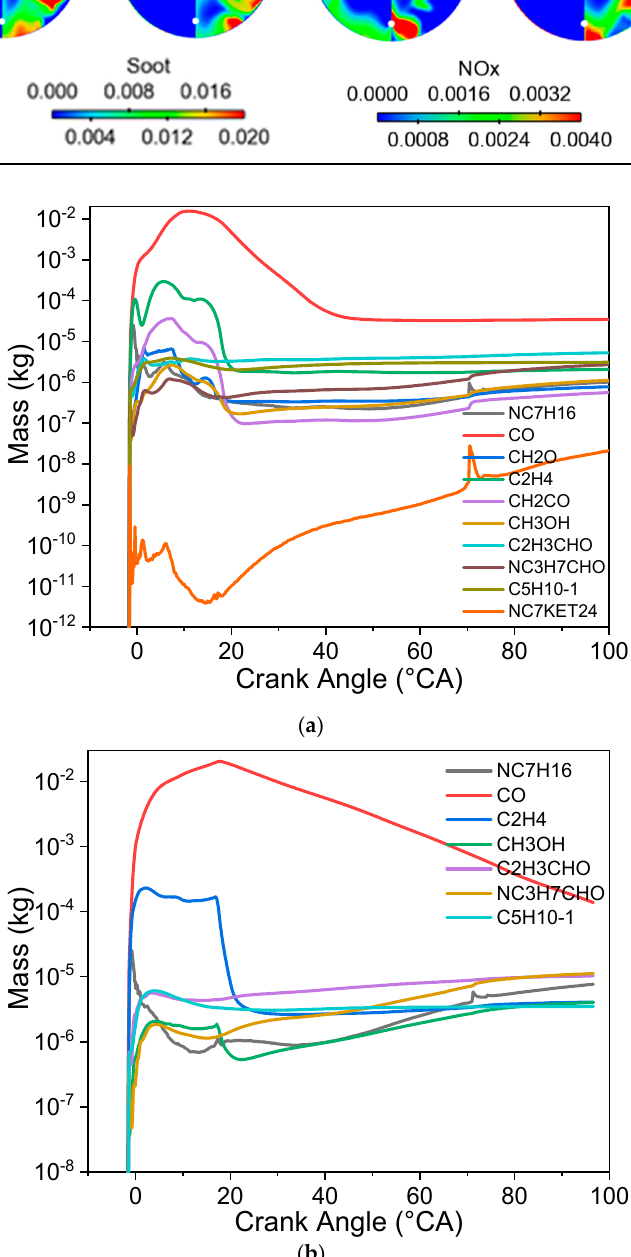
Figure 8. The trace comparison of main intermediate species for the rectangle ( a ) and triangle ( b ) shapes.